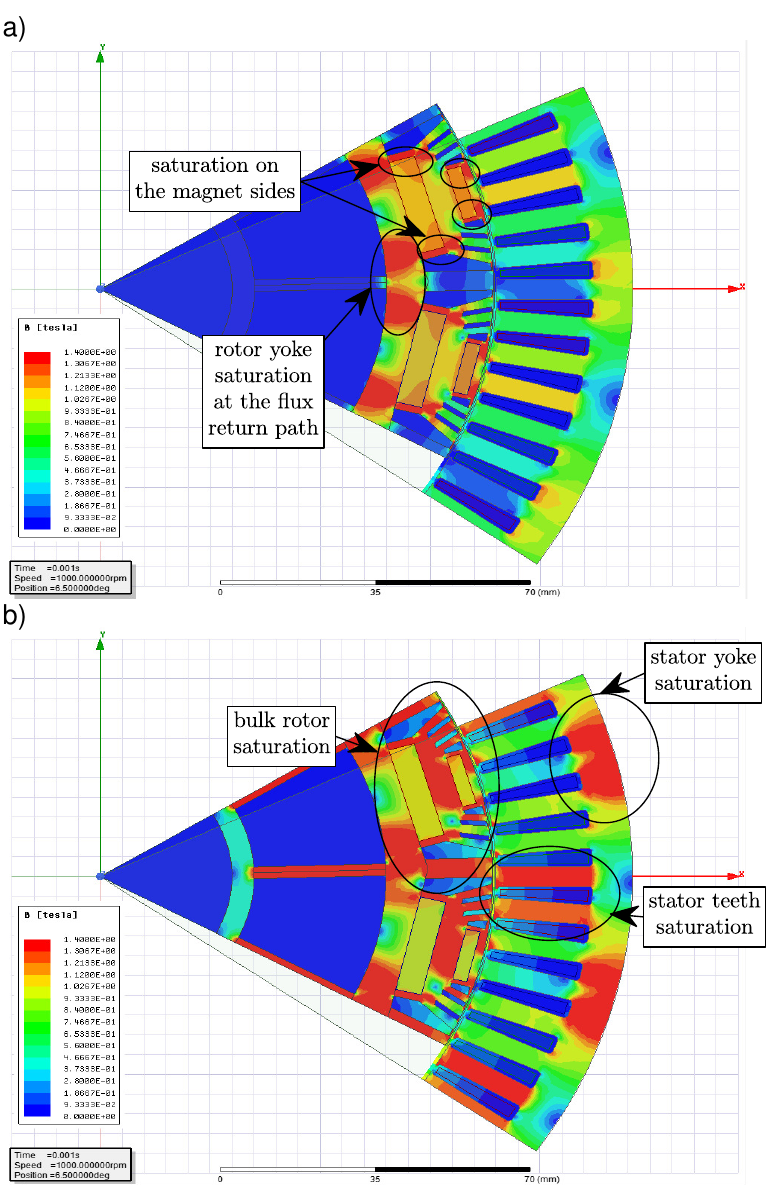
Figure 5. Magnetic circuit saturation of the BMW i3 traction machine: ( a ) flux density plot at no current state, ( b ) flux density plot at the working point corresponding to the peak torque ( i d _Tpk = − 401 A, i = 399 A). These plots were obtained with the “Ansys Maxwell” q _Tpk